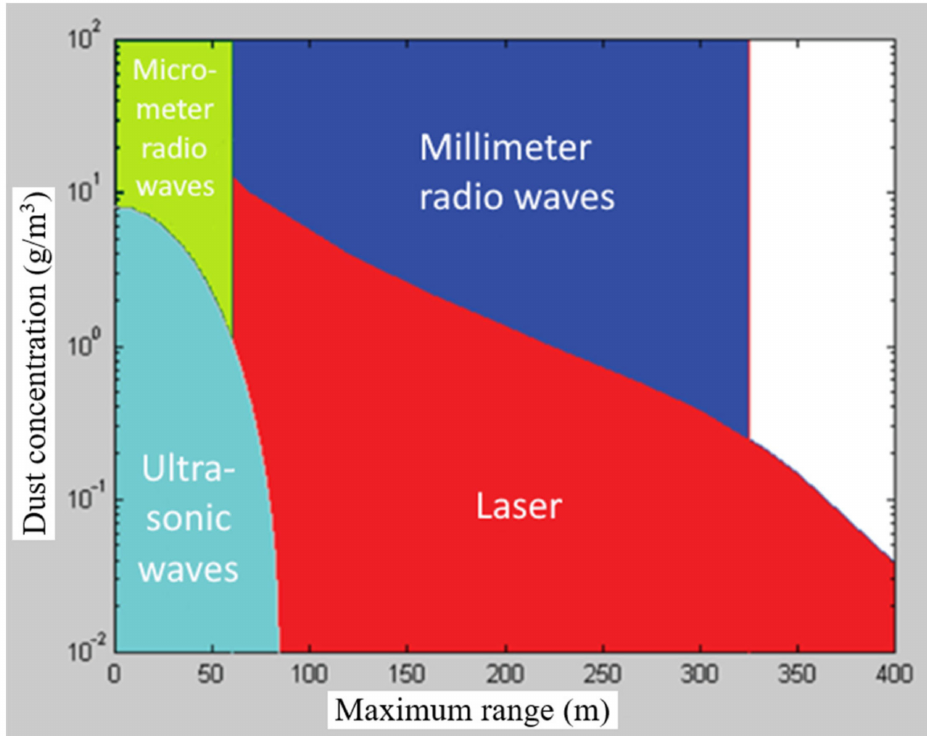
Figure 4. Graph of the effective selection of the appropriate measurement technology. Adapted from ref. [30].